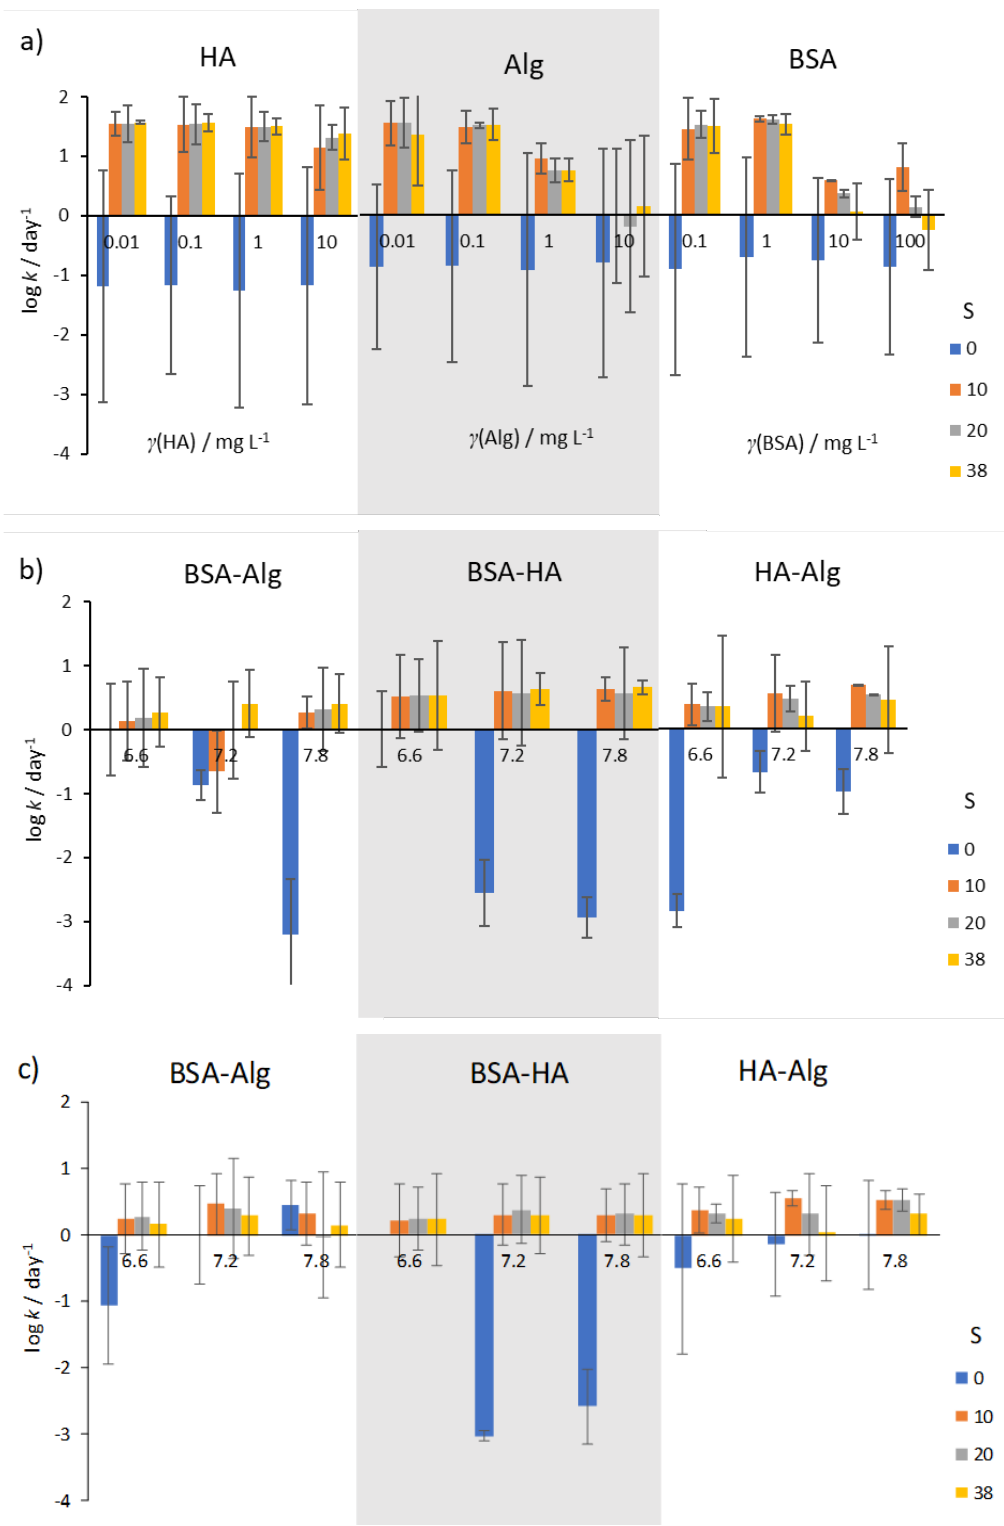
Figure 5. Kinetics of AgNP SPR absorption peak reduction in the presence of ( a ) NOM, ( b ) combinations of NOM at various pH (indicated under the bars), and ( c ) combinations of NOM at various pH and reduced O 2 saturation (50%). Error bars indicate the standard deviation.